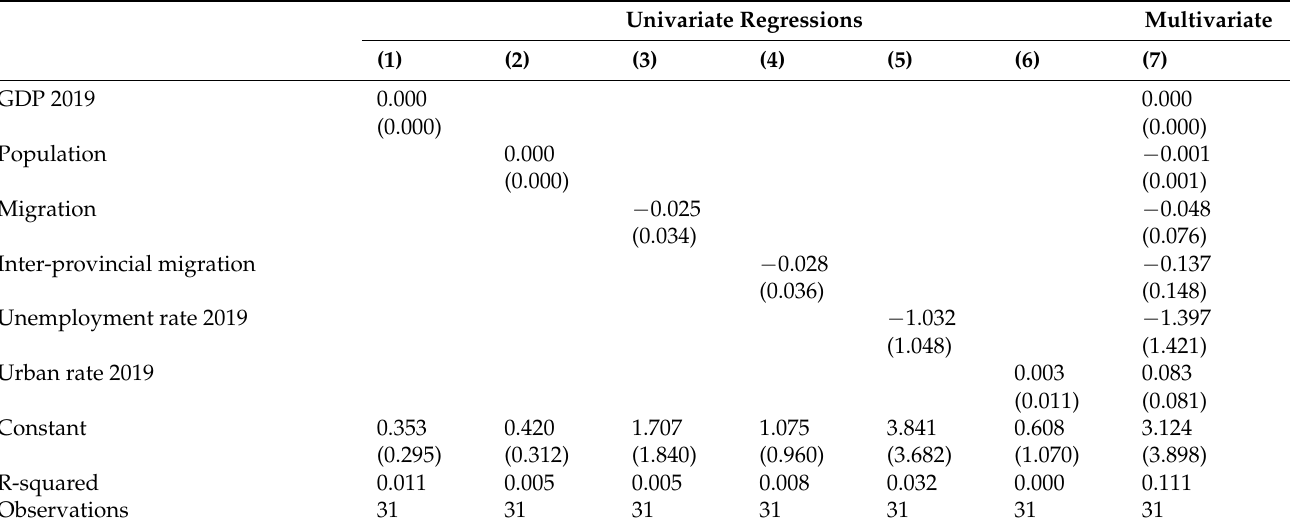
Table A1. The relationship between COVID-19 intensity index and major socioeconomic variables.